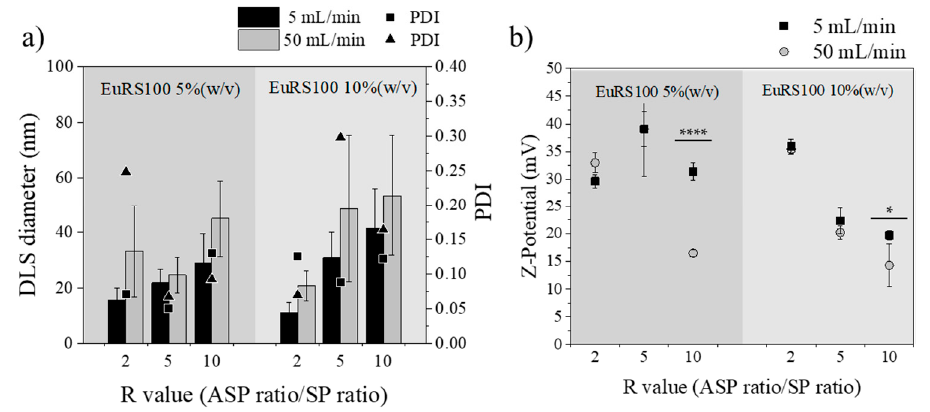
Figure 7. ( a ) DLS diameter of Eudragit ® RS100 5% (w/v) and 10% (w/v) EtOH:acetone of total flow 5 mL/min (black) and 50 mL/min (gray) of different R values (n = 3). Polydispersity index (PDI) of 5 mL/min ( ■ ) and 50 mL/min ( ▲ ), ( b ) Z-potential of 5 mL/min (black ■ ) and 50 mL/min (gray ● ) (**** p < 0.0001), (* p < 0.05).